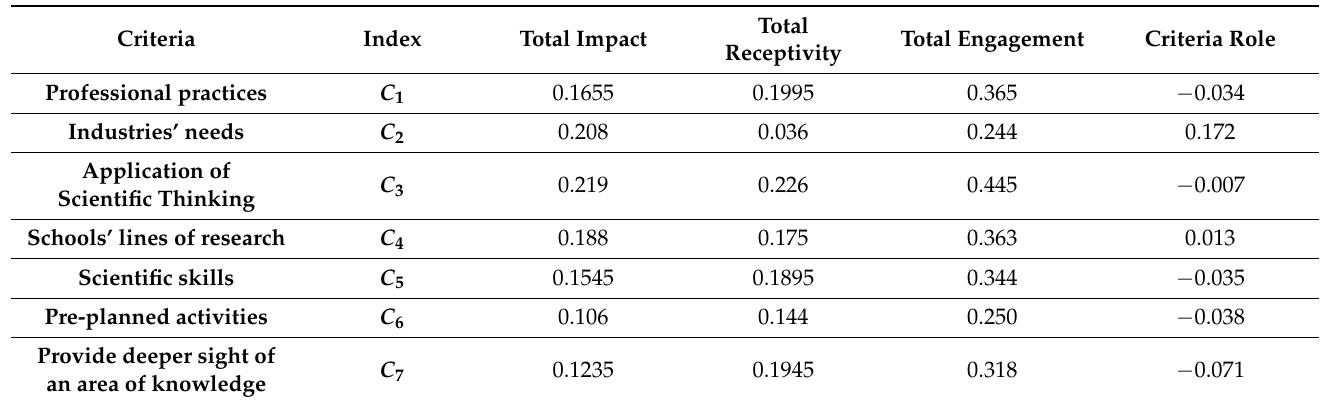
Table 9. WINGS results.